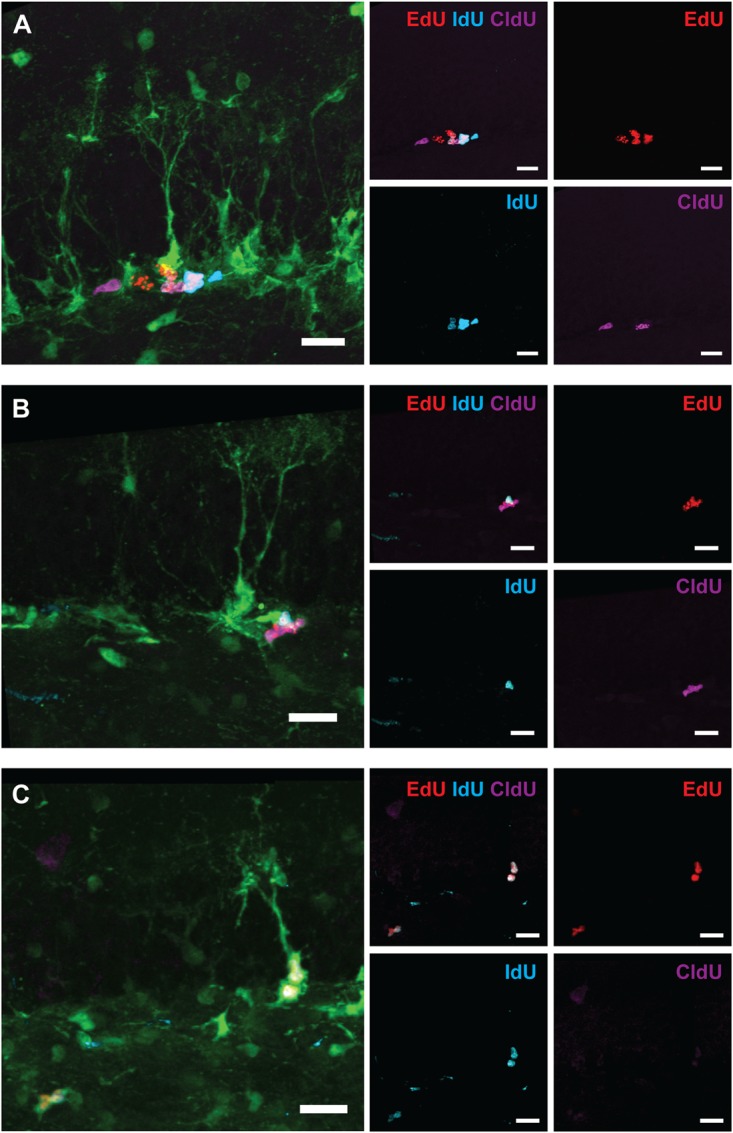
Examples of labeled cells analyzed in Figure 7 (6-month experiment – scheme in Figure 7A). (A) EdUonly, IdUonly, CldUonly, and EdU+IdU+ labeled ANPs. (B) IdU+EdU+ and CldU+EdU+ labeled ANPs. (C) IdU+EdU+ labeled RGL and ANPs. Scale bar shows 20 μm.